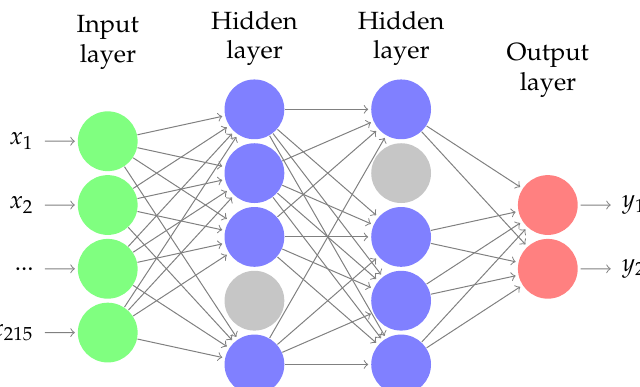
Figure 1. Neural Network Architecture. Grey nodes represent the dropout technique used for